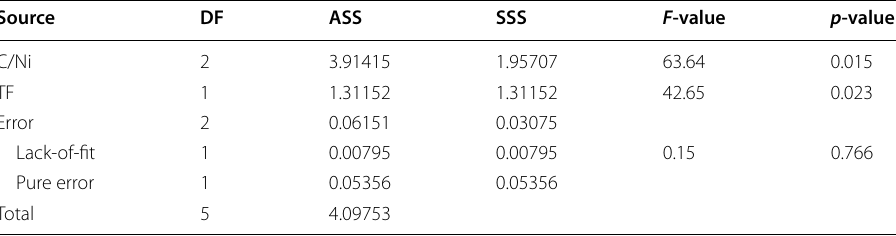
DF degrees of freedom, ASS adjusted sum of squares, SSS sequential sums of squares